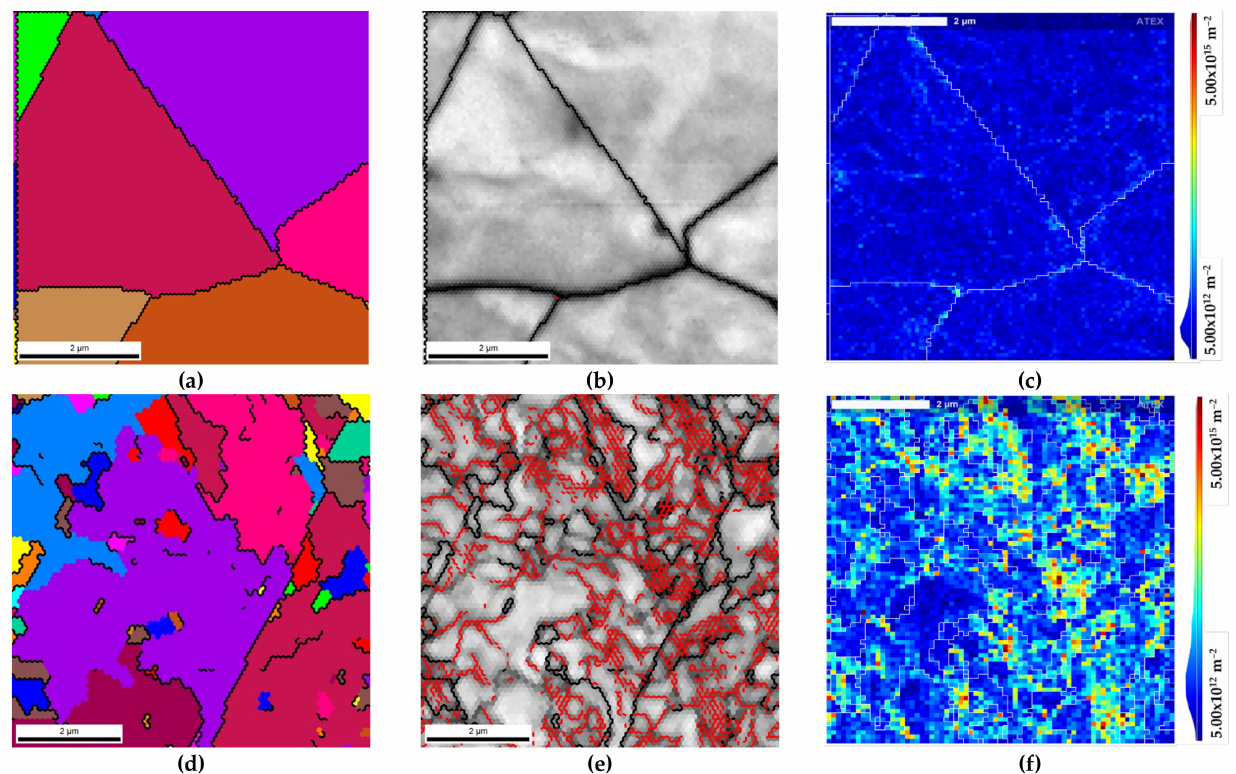
Figure 20. EBSD ( a , b ) grain size maps, ( b , e ) image quality with delineated high- and low-angle boundaries (black and red, respectively), and ( c , f ) estimated geometrically necessary dislocations (GND) map of ( a , b , c ) Ni and ( d , e , f ) Ni/CNT